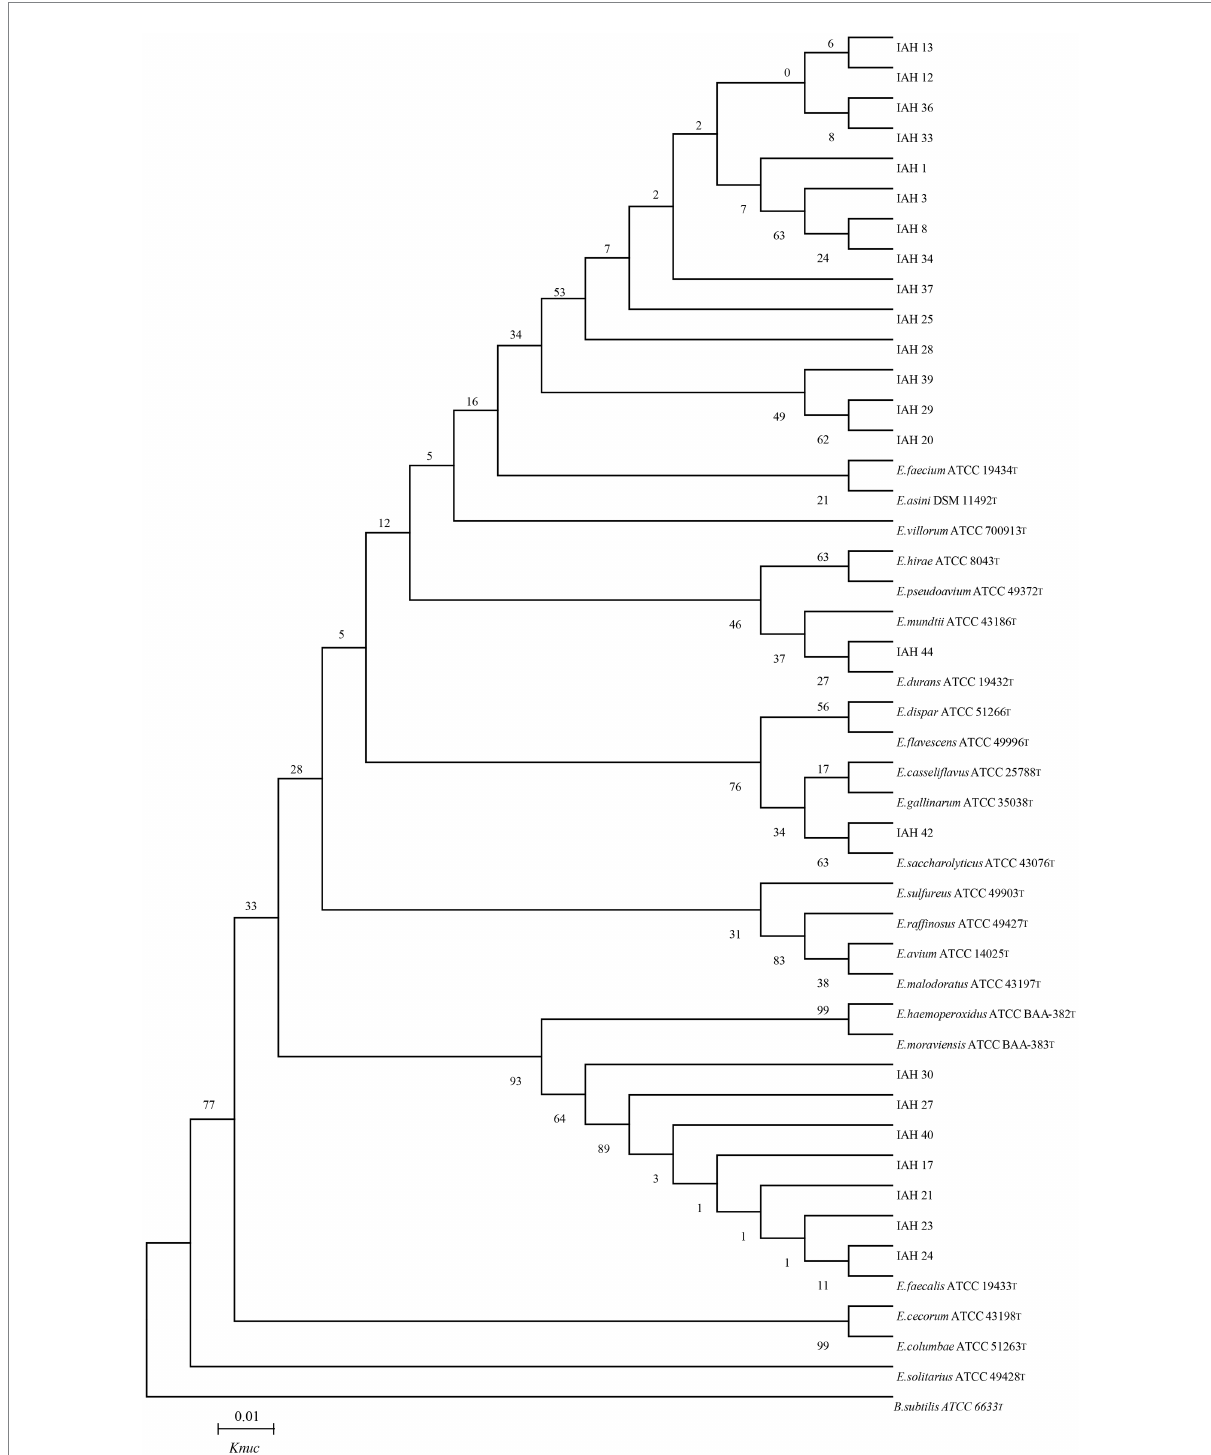
FIGURE 2 Phylogenetic tree showing the relative position of Enterococcus species and representative strains isolated from natural grasses as inferred by the neighbor-joining method of complete 16S rDNA sequences with 1,000 replicates. Reference sequences of type strains from GenBank are used for comparison, Bacillus subtilis is used as the outgroup. The width is proportional to terminal branch lengths (1% sequence divergence, shown as a scale bar at lower right). E., Enterococcus . K nuc, nucleotide substitution rates.